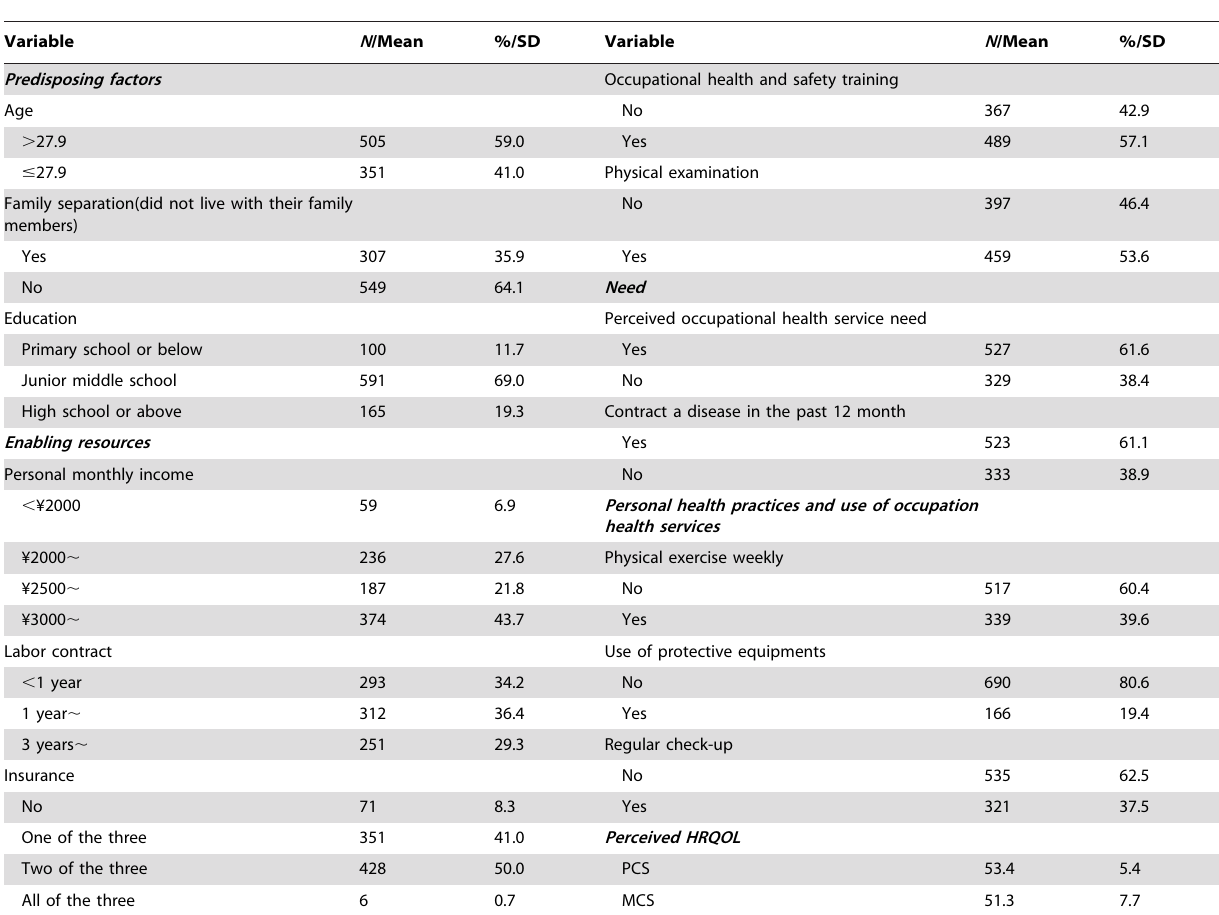
Table 4. The latent and measured variables used in the analysis (N =856).